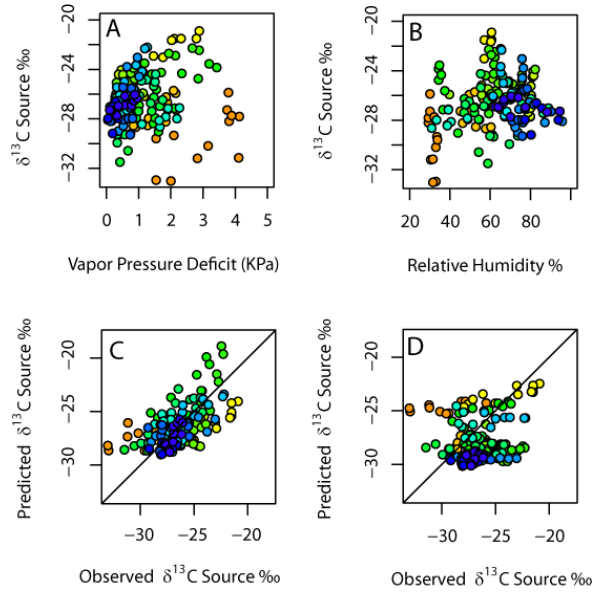
Figure 3. Correlation analysis δ 13 CO 2 source (δ s ) and metrics of atmospheric water Fig. 3. Correlation analysis δ 13 CO 2 source ( δ s ) and metrics of vapor. The color of points corresponds with the color code for individual sites denoted atmospheric water vapor. The color of points corresponds with the in Fig. 1. Global correlations for growing season vapor pressure deficit and δ s (A). Global correlations for growing season relative humidity and δ s (B). Comparisons color code for individual sites denoted in Fig. 1. Global correlations between observed δ s and predicted δ s values for the Leuning Model driven by vapor pressure deficit (C) and for the BWB Model driven by relative humidity (D). See table 1 for growing season vapor pressure deficit and δ s (A) . Global correla- for global and local statistics and see Table 2 for model parameters. tions for growing season relative humidity and δ s (B) . Comparisons between observed δ s and predicted δ s values for the Leuning Model Figure 2. Global coherence of δ 13 CO 2 source (δ s ) anomalies to the atmosphere. The Fig. 2. Global coherence of δ 13 CO 2 source ( δ s ) anomalies to the at- driven by vapor pressure deficit (C) and for the BWB Model driven network of sites included in our analysis (A), where the size of points corresponds with length of the dataset (see Table1) and the color of the point corresponds with latitude mosphere. The network of sites included in our analysis (A) , where by relative humidity (D) . See Table 1 for global and local statistics and also the seasonal distribution of points in panel B. The seasonal distributi on of δ s the size of points corresponds with length of the dataset (see Table1) and see Table 2 for model for all sites included in our analysis (B). and the color of the point corresponds with latitude and also the sea- sonal distribution of points in panel (B) . The seasonal distribution of δ s for all sites included in our analysis (B) .